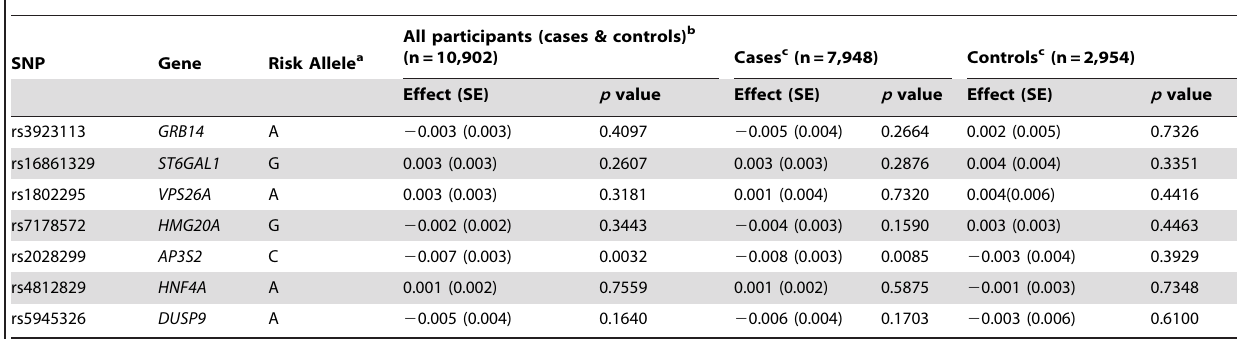
Table 5. Association of 7 SNPs with BMI in the Japanese population.